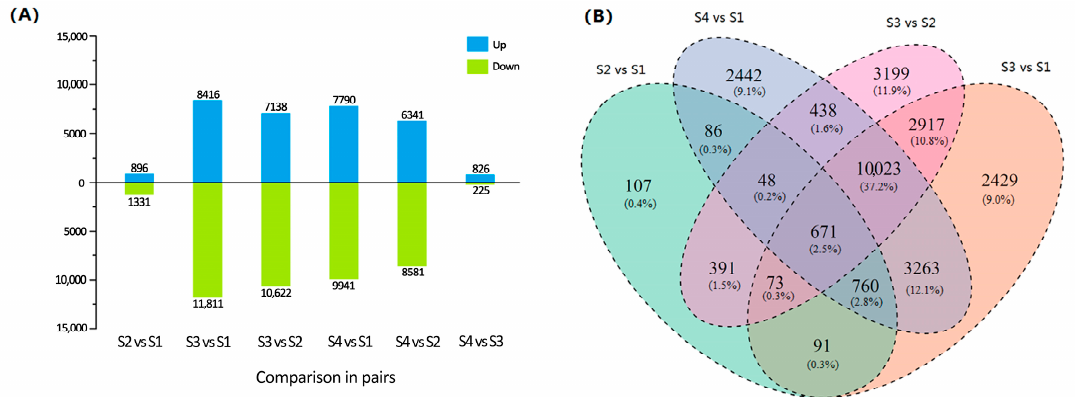
Figure 3. The distribution characteristics of differentially expressed genes (DEGs) in stem mustard during stem development. ( A ) The number of DEGs in any two different stages. The number of up- and down-regulated genes is presented via the bars above and below the x -axis, respectively. ( B ) Venn diagram of DEGs commonly and uniquely expressed among the comparison in pairs.